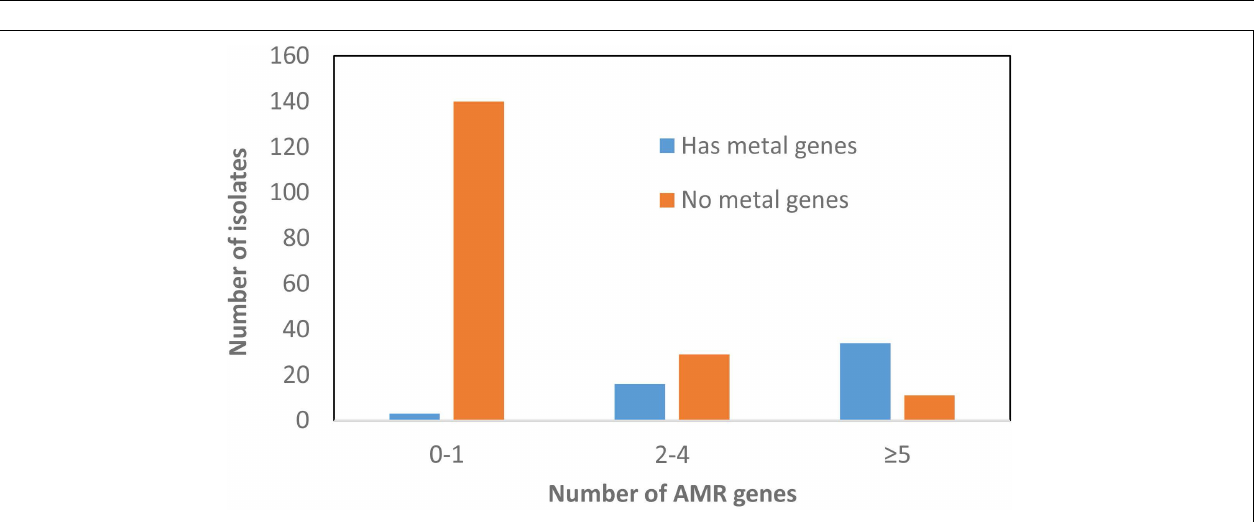
FIGURE 4 | Plasmid-resistance gene associations. The information above relates to plasmids with typing information and does not include those with zero or multiple replicon types.